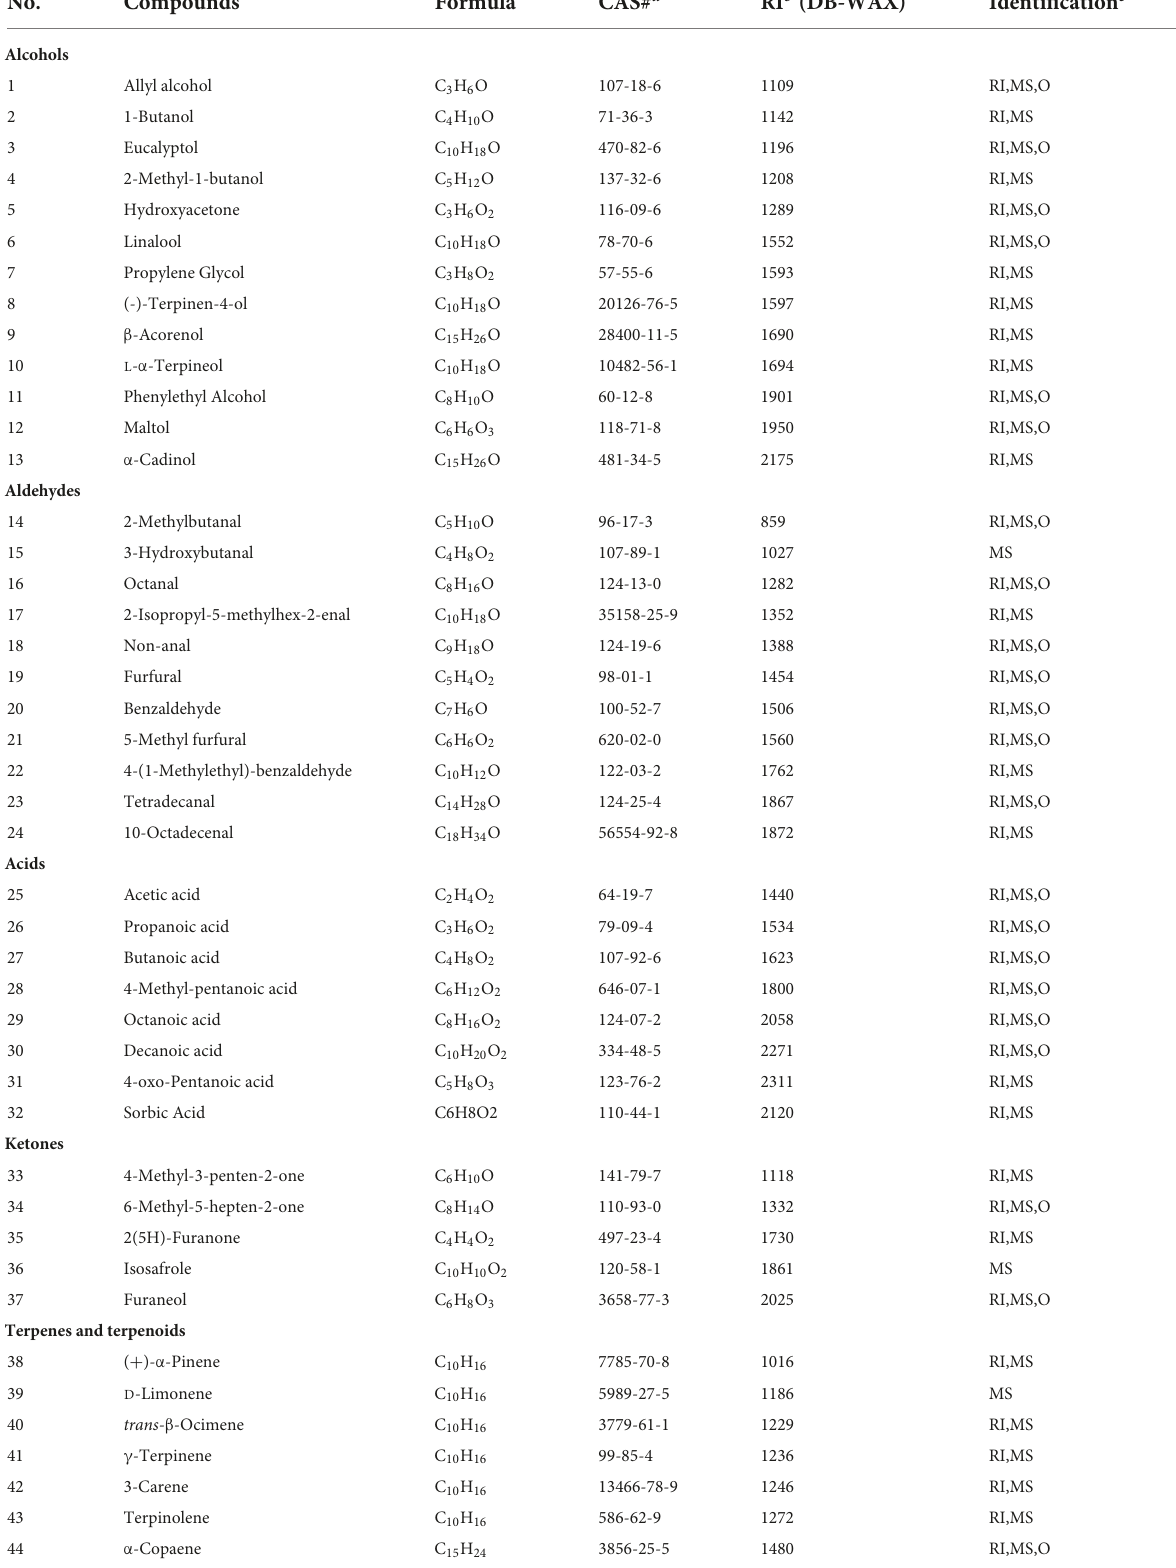
TABLE 1 Volatile odorants of HPBF identified by SPME-GC-MS/GC-O stored for 168 days.